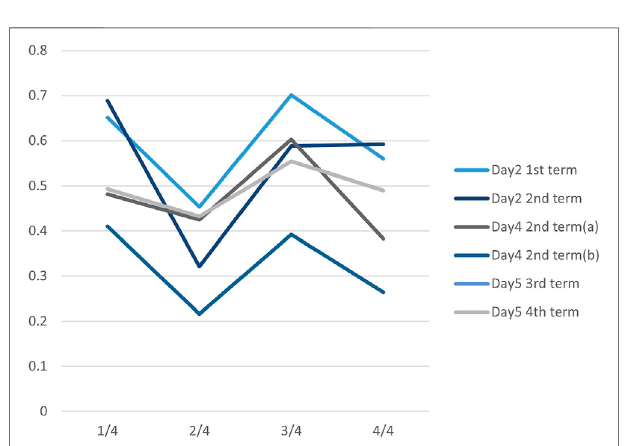
FIGURE 7 | The transition of the ratio of walking.